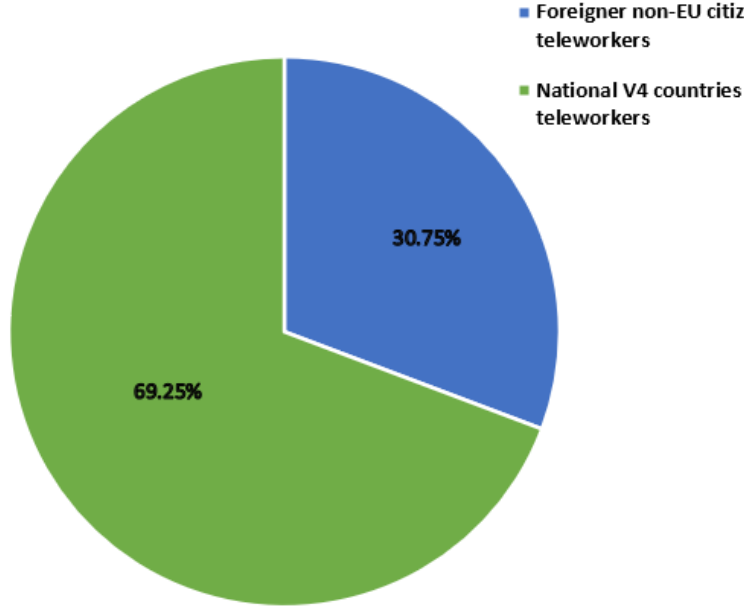
Figure 1. Foreign non-EU citizen teleworkers vs. national V4 countries teleworkers. In total, 22% of the respondents worked in Czech (61 national workers, 31 foreign workers), 31% worked in Hungary (96 national workers, 36 foreign workers), 24% worked in Poland (69 national workers, 32 foreign workers), and 23% worked in Slovakia (67 national workers, 31 foreign workers); see Figure